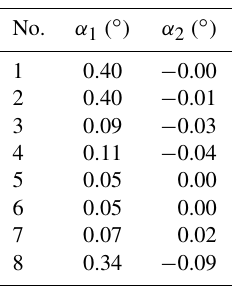
Figure 7. Example of point cloud densification after adjustments of the system: (a) result of an indoor point cloud densification; (b) pic- ture of the scene. Table 5. Variability of α 1 and α 2 parameters during reproducibility test.